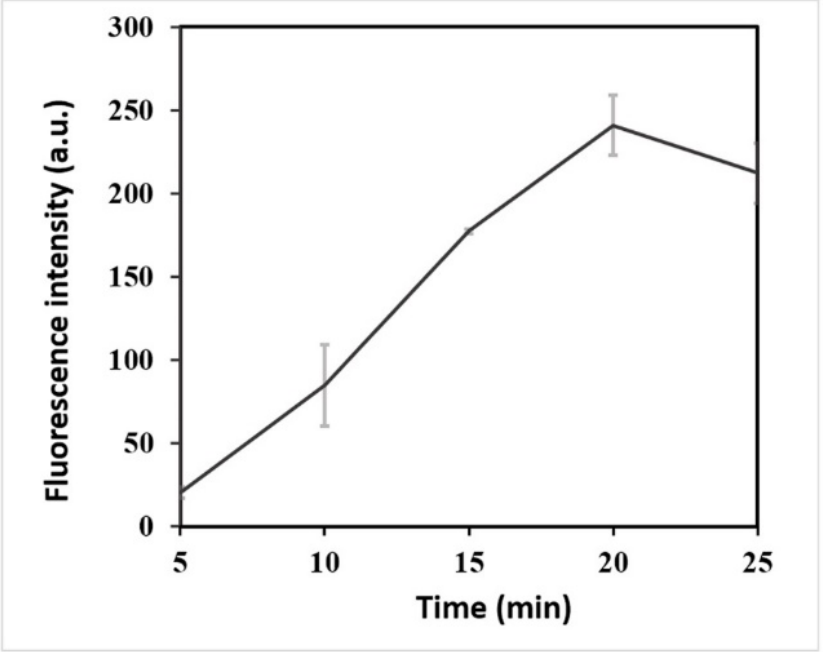
Figure 1. Determination of optimal action time of LAMP. Fluorescence intensity with different reaction time (5, 10, 15, 20, and 25 min) of LAMP.